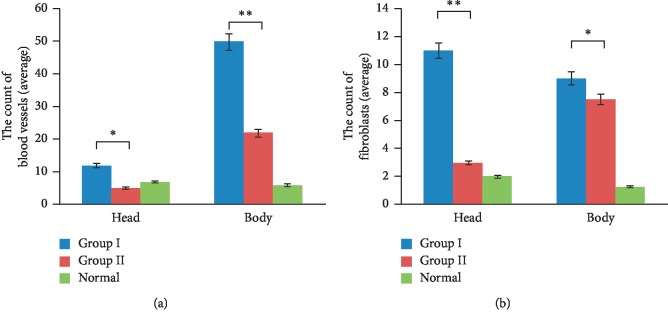
MMC inhibits corneal neovascularization and the proliferation of fibroblasts in pterygium tissues. (a, b) The number of blood vessels (a) and fibroblasts (b) in pterygium samples from group I and group II patients was counted under optical microscope after histochemical analysis (×400). Mean value of per field was shown (five randomly selected visual fields). Data are expressed as the means ± SD of three samples per group. ∗P < 0.05 and ∗∗P < 0.01. Normal corneal tissues serve as controls.